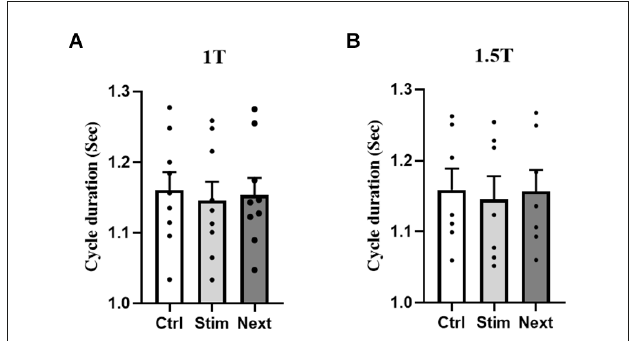
FIGURE5 LCathodeConfiguration.Nostatisticaldifferenceincycledurationwas observed between the control, stim, or next cycles at 1 T (A) and 1.5 T (B) .